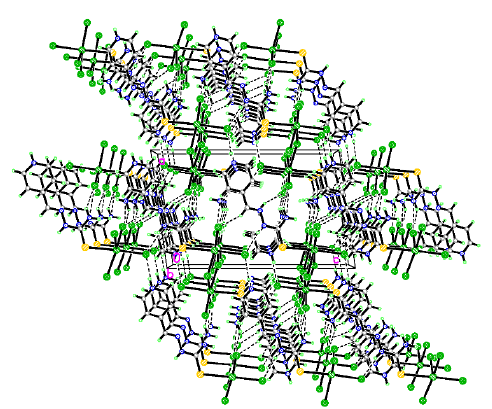
Figure 9. The 3D Structure of [Bi(HQ)(Cl) 4 ] n formed by labile interactions similar to hydrogen bonds.